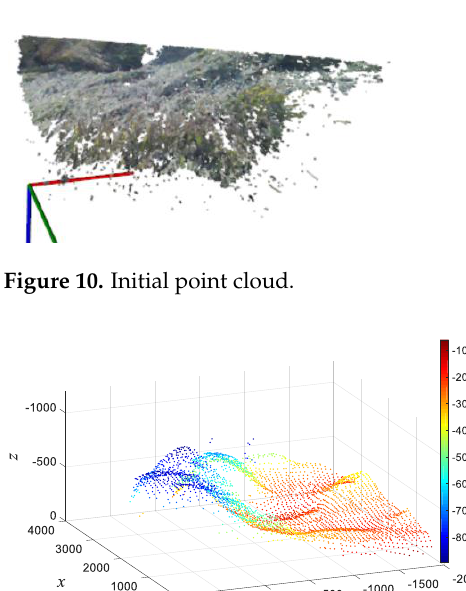
Figure 9. Parallax map.